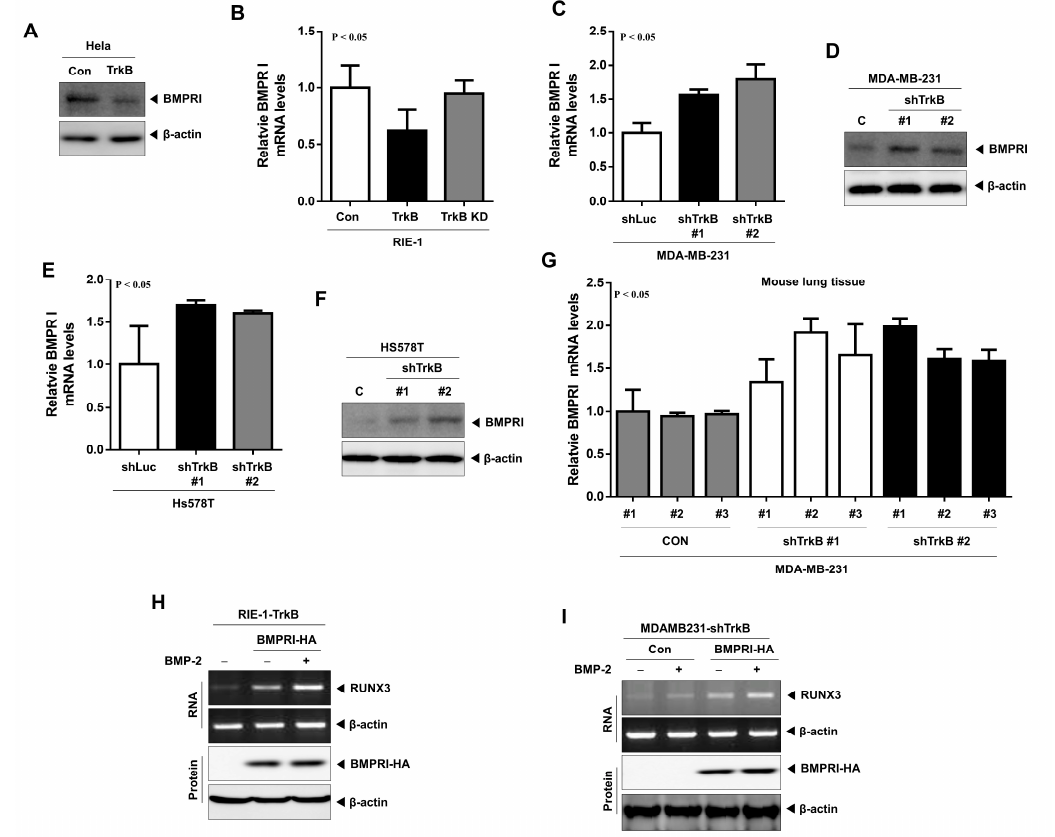
Figure 6. TrkB suppressed BMP-mediated RUNX3 expression by depleting BMPRI. ( A ) Western